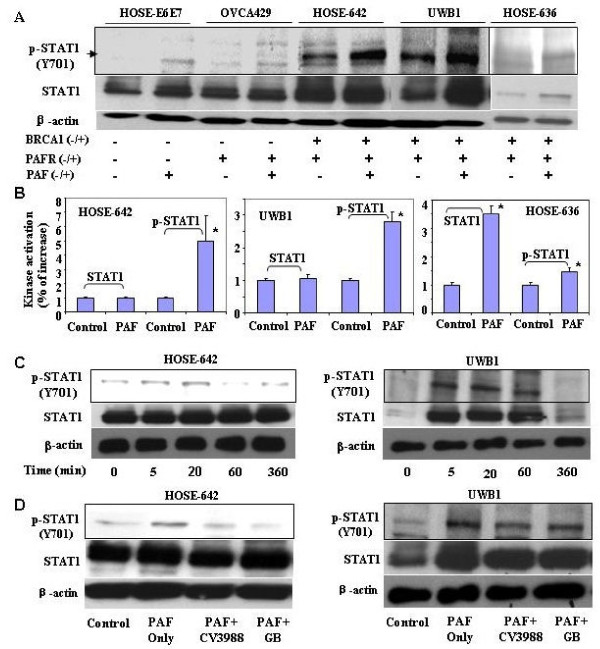
Activated phospho-STAT1 in BRCA1+ ovarian epithelial cells. (A) Wild type HOSE-E6E7 and OVCA429 cancer cells and BRCA1-mutant at-risk (HOSE-642, HOSE-636) cells and BRCA1-mutant ovarian cancer cells (UWB1) were subjected to PAF treatment for 20 minutes and phospho-STAT1 (Y701) detection by western blot. (B) Summary of intensity of SATA1 and phosphor-STAT1 induced by PAF treatment in HOSE-642, UWB1 and HOSE-636 cells. Phosphor-STAT1 was significantly (p < 0.01) increased in all BRCA1-mutant cells. (C) Activation of phosphor-STAT1 at different time points (0, 5, 20 60 min and 360 min) of PAF treatment (100 nM) in BRCA1-mutant HOSE-642 and UWB1 cells. (D) Equal amount of protein lysate of the cells of untreated, treated with PAF (100 nM) alone or in combination of PAF and PAFR-inhibitor (10 μM) and GB (100 μM) were applied in western blot detection. DMSO and pure IgG (not shown) were used as control treatment for 20 minutes in both HOSE-642 and UWB1 cells. Equal loading of protein was calibrated with expression of β-actin.